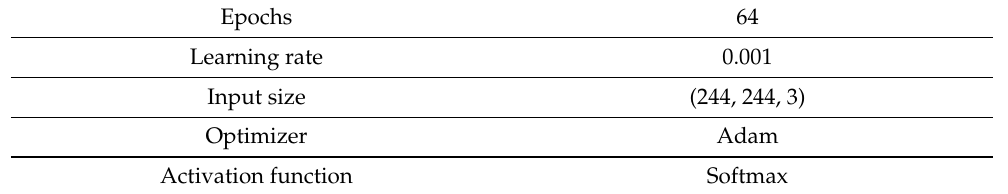
Table 3. Model parameters for air tire pressure fault.